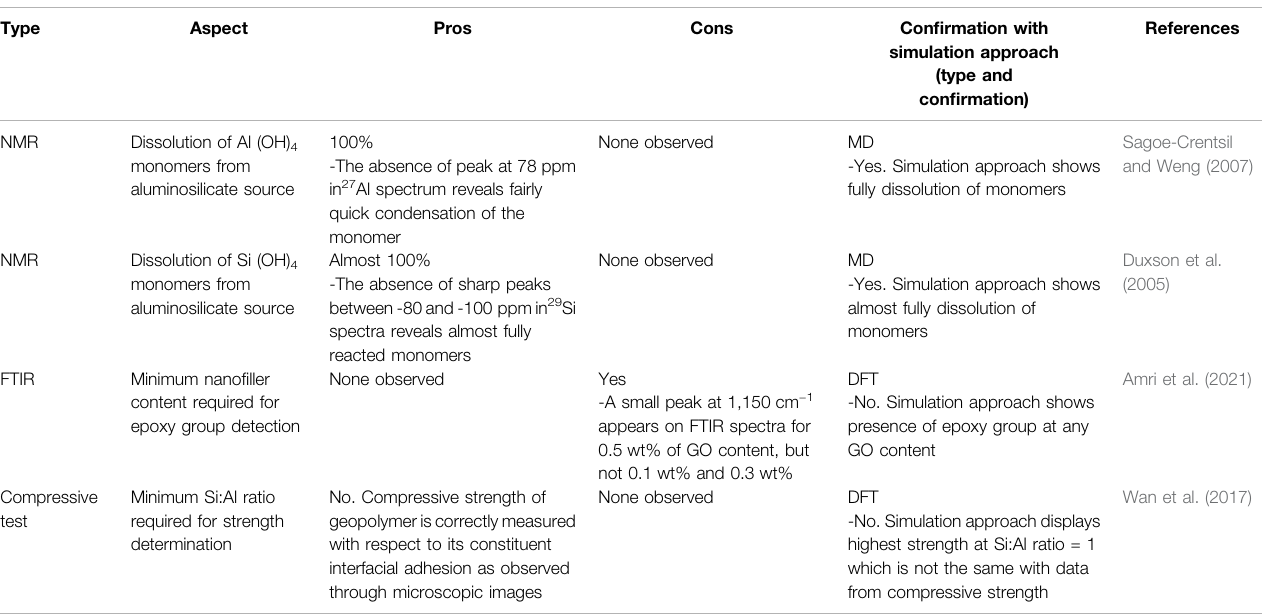
TABLE 7 | Pros and cons of experimental modeling in